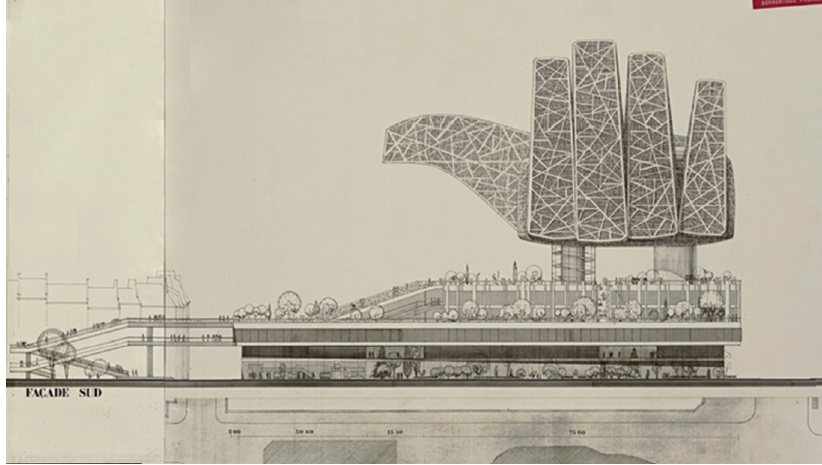
Figure 4. Bergerioux, André. Project No 006; South façade. (Submission. Concours International d’idées pour la Réalisation du Centre du Plateau Beaubourg. Paris: Délégation à la réalisation du Centre du Plateau Beaubourg, 1970. 1992037/016 (Juillet 1971); Dossiers des